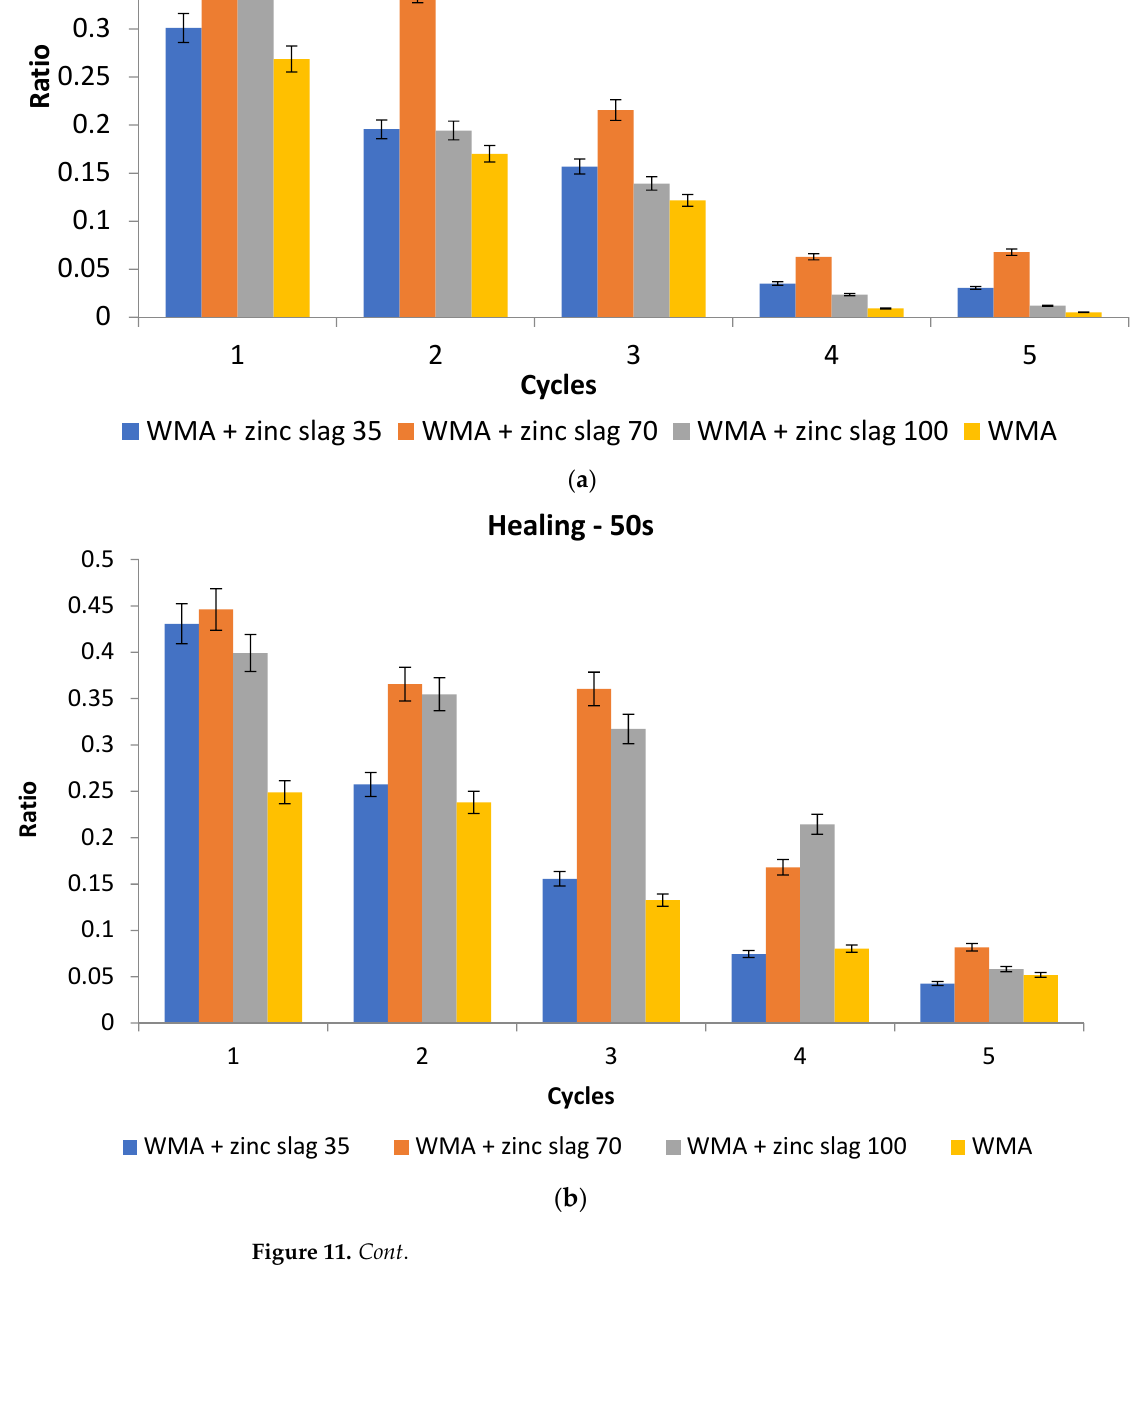
( c ) Figure 11. The healing of the samples under microwave heating at ( a ) 40-s, ( b ) 50-s, and ( c ) 60-s cycle durations. Figure 12 shows the average temperature of the specimens at different microwave induction heating durations. As the figure reveals, increasing zinc slag content in the mix- ture enhanced the heat generation capability, such that the samples with 100% zinc slag filler had a 73% higher average surface temperature than the control specimens.